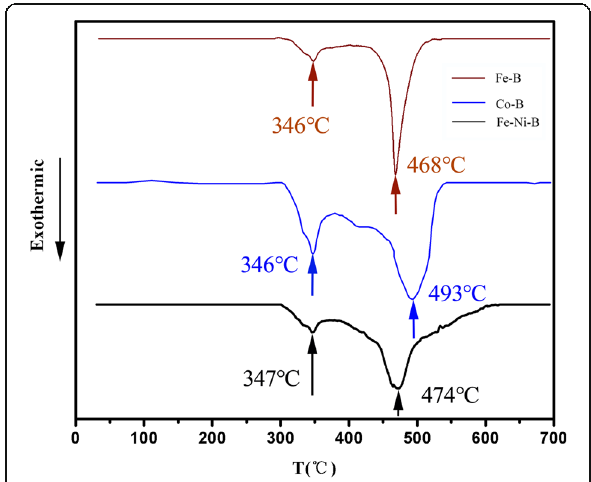
Fig. 2 DSC curves of Fe-B, Fe-Ni-B, and Co-B particles